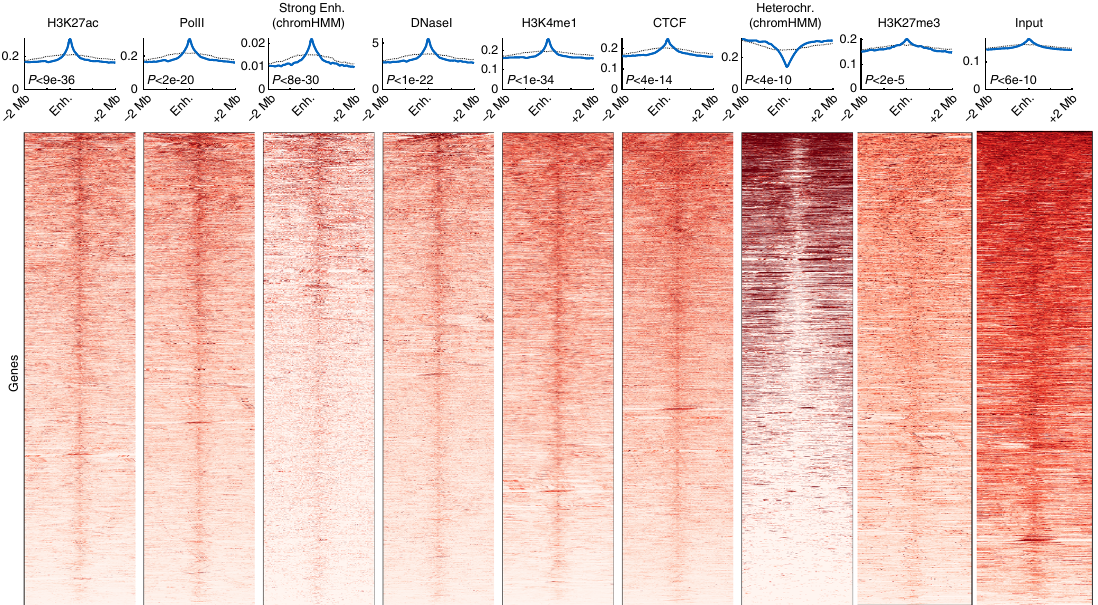
Fig. 3 Chromatin marks surrounding predicted enhancer regions. Chromatin marks at 4 Mb windows centered around 17,788 putative enhancer regions, predicted using PSYCHIC (FDR < 1e-2) for adult mouse cortex Hi-C data 25 . Shown are typical enhancer marks (H3K27ac, H3K4me1), along with PolII and CTCF ChIP-seq, chromHMM classi fi cations, H3K27me3, and DNaseI hypersensitivity assays. Blue lines mark the average signal over the predicted enhancer Hi-C bins. Black dotted lines mark the signal averaged over a random set of genomic loci, sampled in 2 Mb windows around promoters. The statistical signi fi cance of each plot ( p value) is calculated by comparing the average signal at putative enhancers with their > 500 Kb